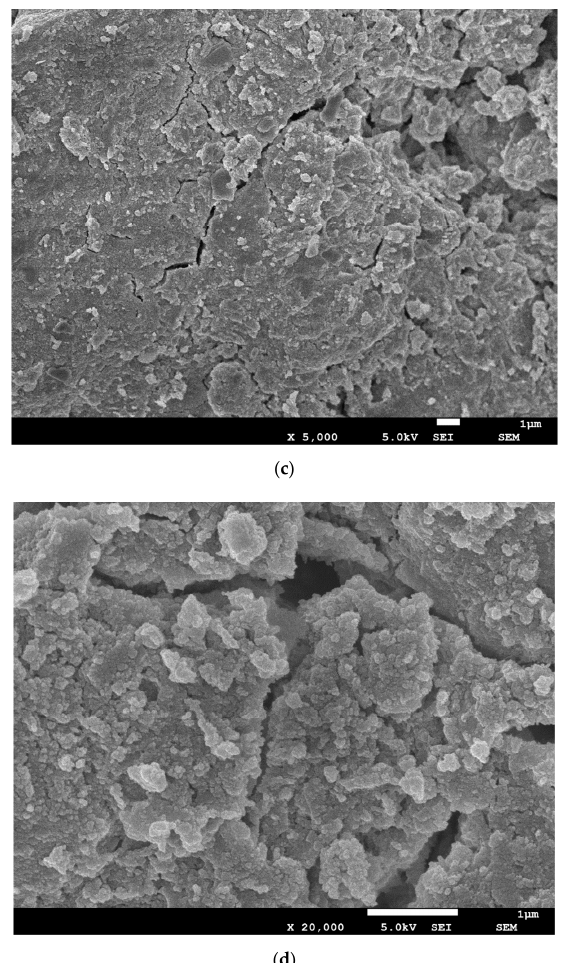
Figure 6. The microstructure of AAS after 28 days of curing. ( a , b ) AAS1, and ( c , d ) AAS2. Table 3. Elemental analysis of AAS.